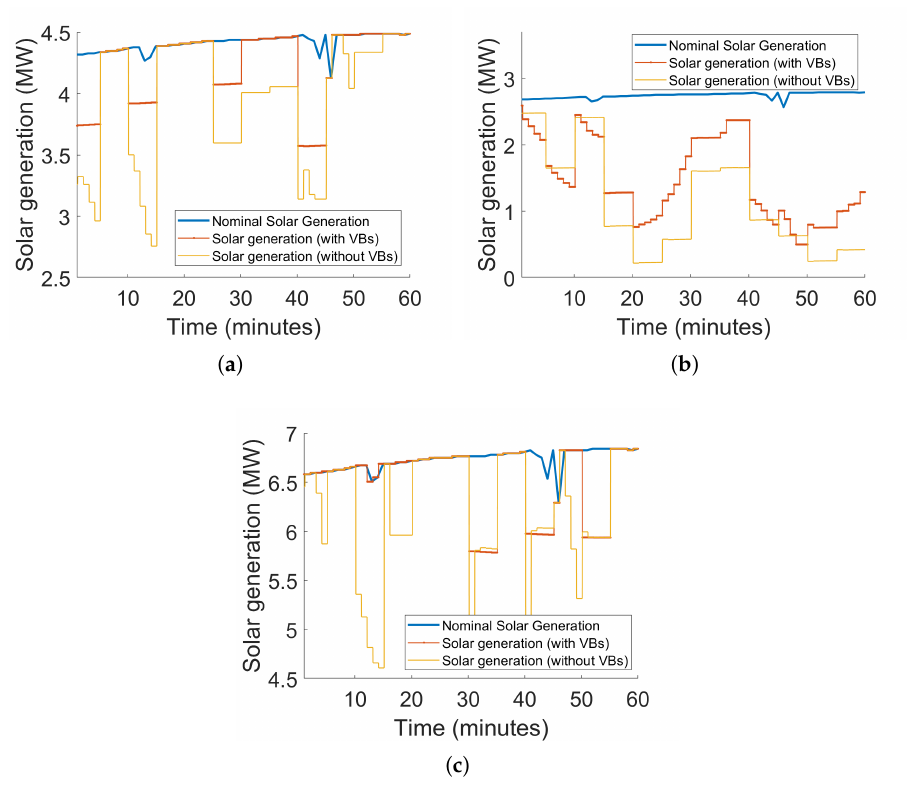
Figure 20. Total solar PV output from all nodes during peak hour (11:00 to 12:00) in the FOL. ( a ) Feeder 1. ( b ) Feeder 2. ( c ) Feeder